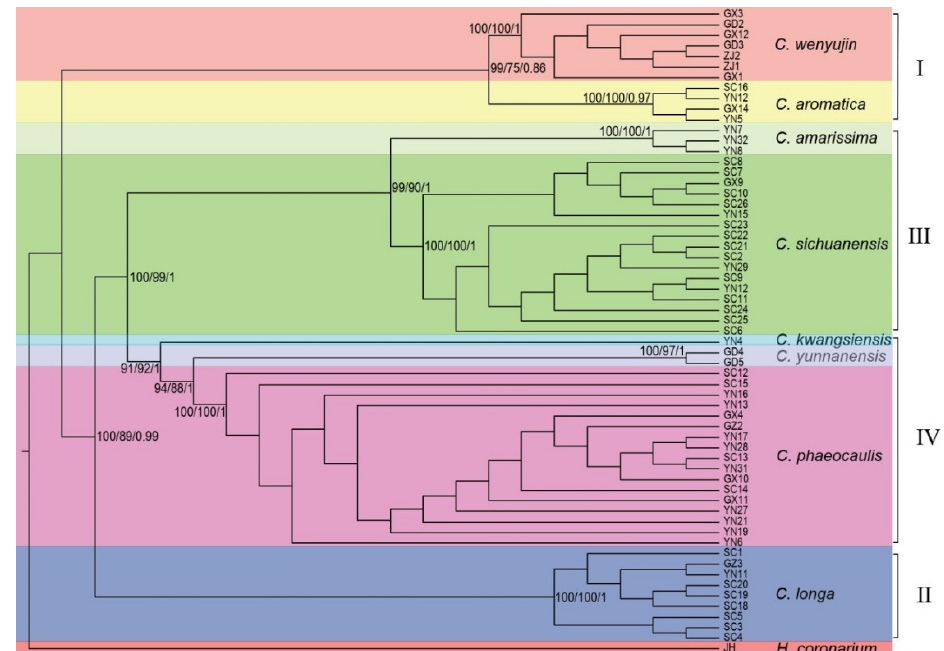
Figure 1. The ML, MP, and BI trees of Chinese Curcuma . The values (maximum likelihood bootstrap/maximum parsimony bootstrap/Bayesian support value) were on the species clade. The Group I consisted of C. wenyujin and C. aromatica ; Group II consisted of C. longa ; The Group III consisted of C. amrissima and C. sichuanensis ; The Group IV consisted of C. kwangsiensis , C. yunnanensis, and C. phaeocaulis .